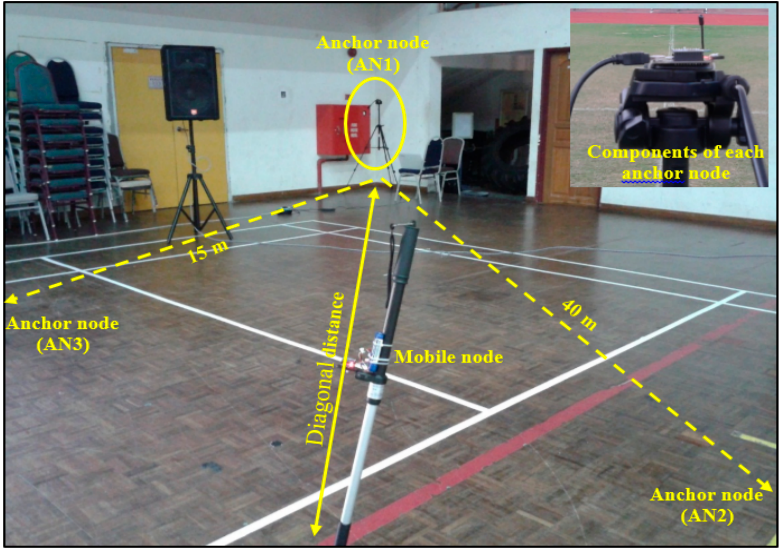
Figure 5. Sports hall (Dewan Gemilang) for the indoor experiment.